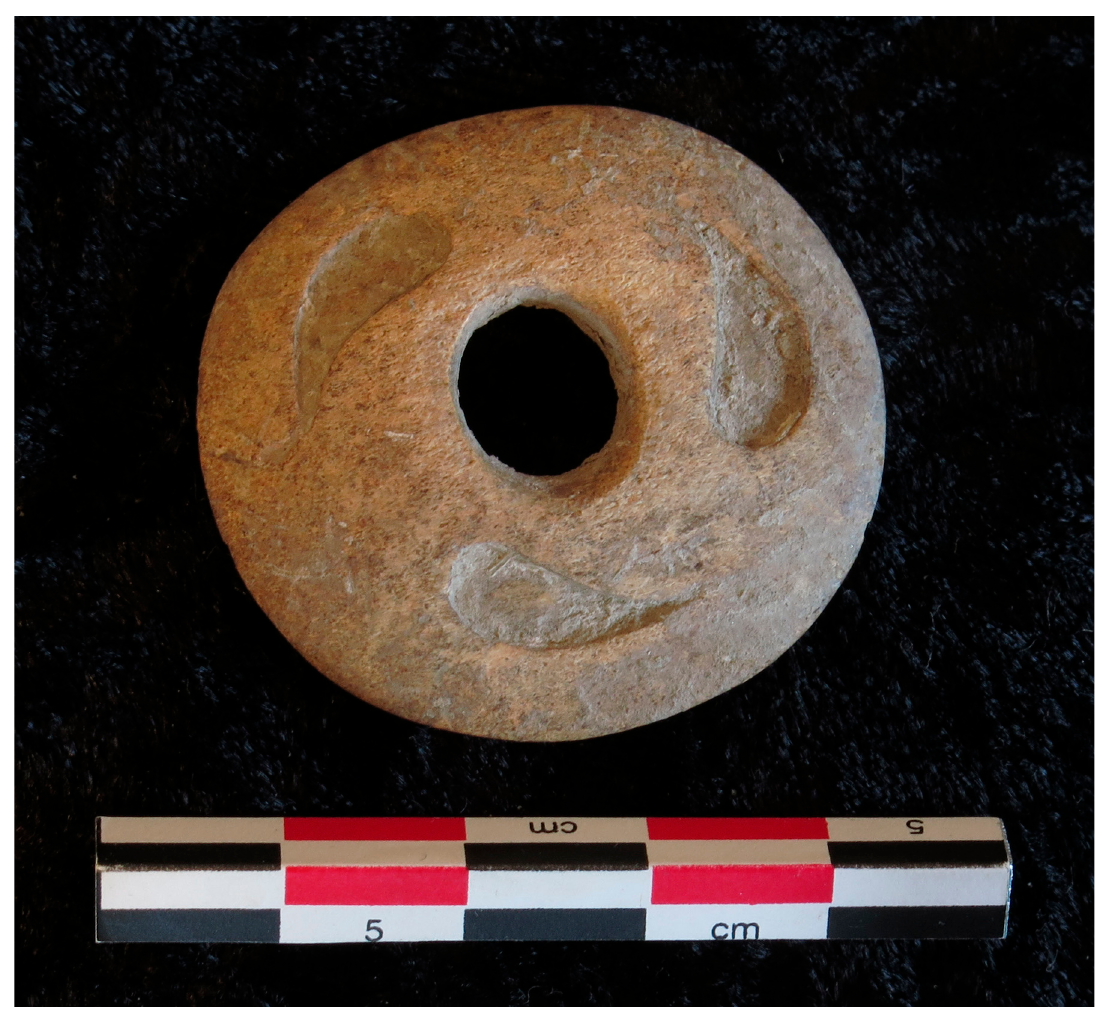
Figure 8. Bone disk with carved bird heads, each with an eye dot in the rounded